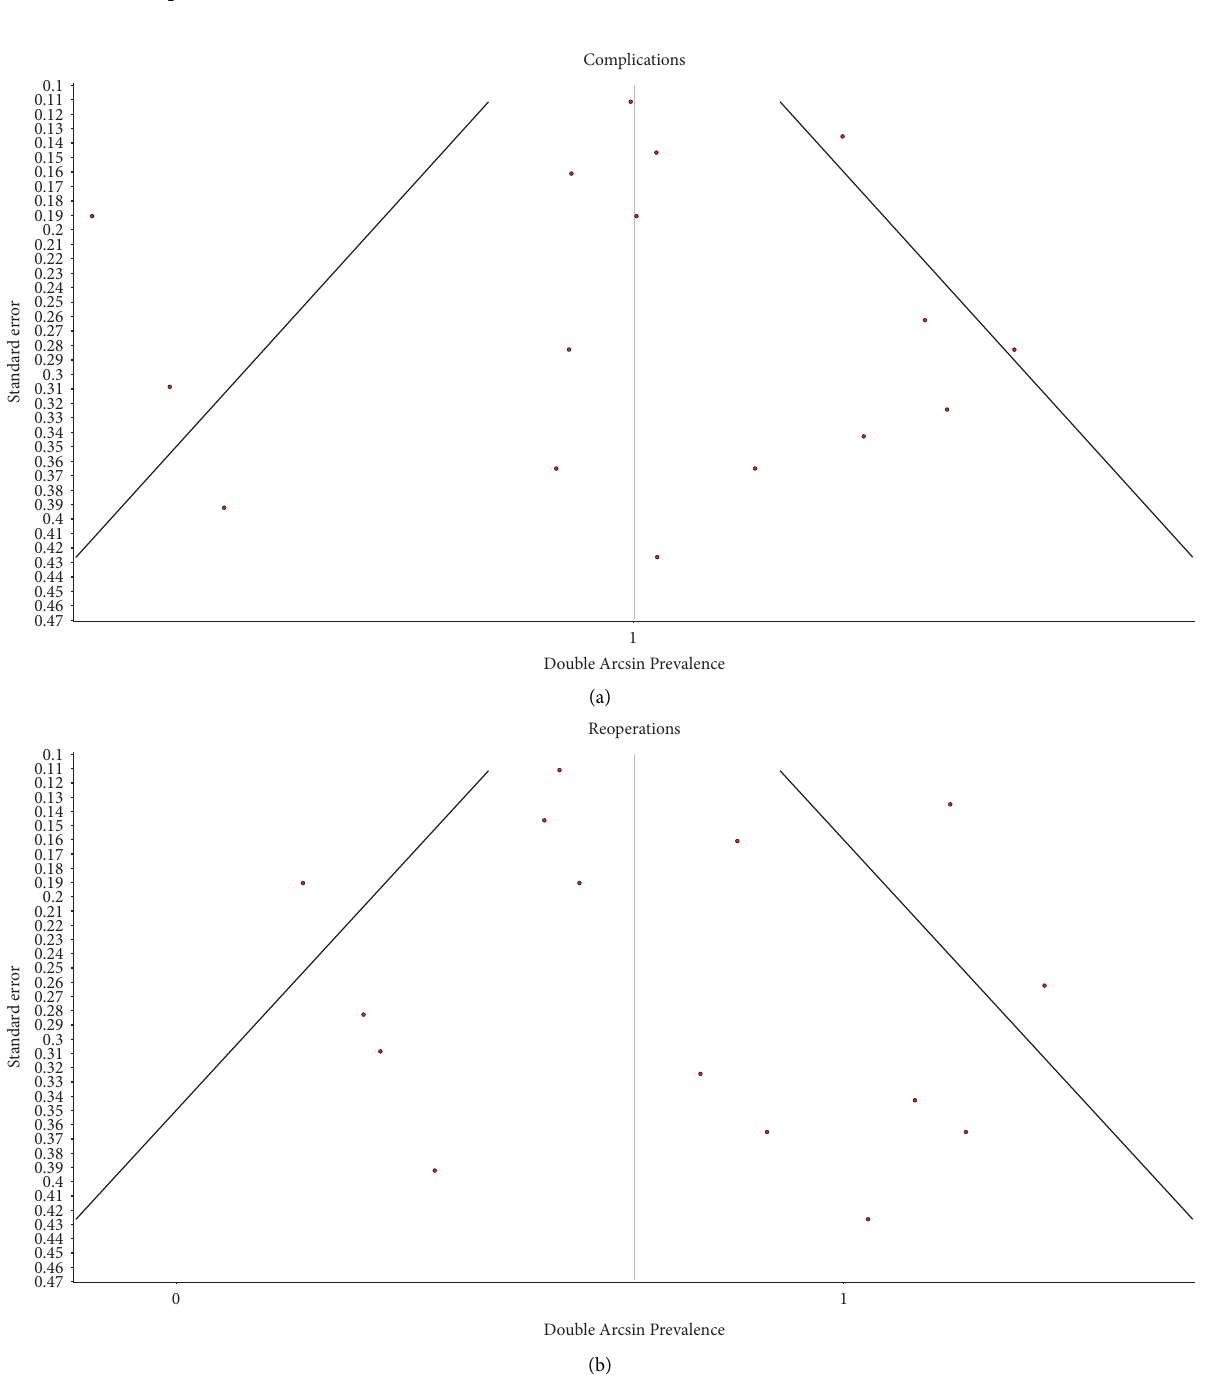
Figure 4: Funnel plots of the meta-analysis of data on (a) complications and (b) reoperations after shoulder arthrodesis and upper trapezius transfer for traumatic BPI, illustrating low publication bias. The area within the funnel represents where 95% of data points would be expected in the absence of publication